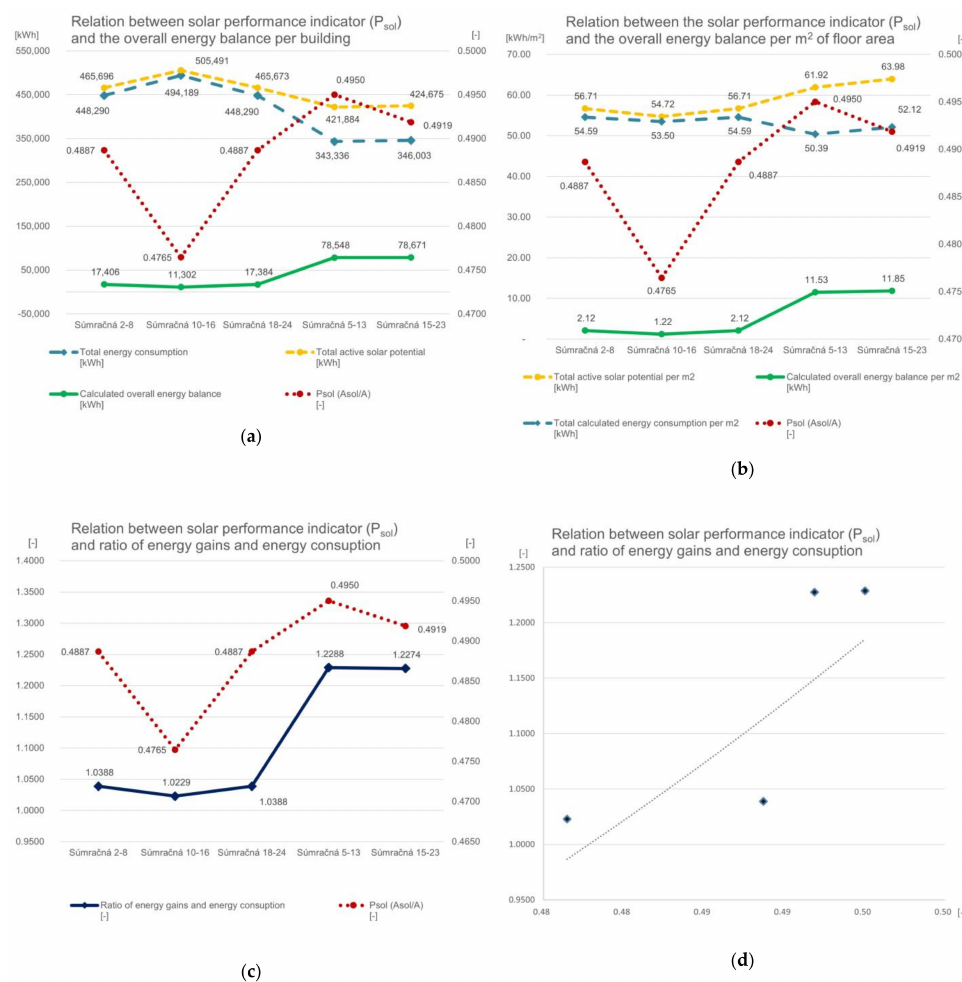
Figure 15. Graphs visualising the calculation results shown in Table 6 and focusing on the relation between particular energy performance values and proposed indicators: ( a ) The chart depicts the correlation of the solar performance indicator (P sol ) and the overall energy balance of the building, although, as expected, both the cumulative values of energy consumption and active solar potential are opposed to this indicator; ( b ) Correlation of the solar performance indicator (P sol ) proposed by the authors and the overall energy performance of the building per square meter of floor area. The relationship between P sol and the ratio of energy gains and energy consumption in the chart shows the correlation between these values. The relation between the parameters is shown alternatively plotted ( c ) on two scales of the y-axis and ( d ) correlating values plotted on x- and y-axes. The results confirm the possible applicability of the indicator under defined conditions for preassessment of building performance by architects and planners in early design